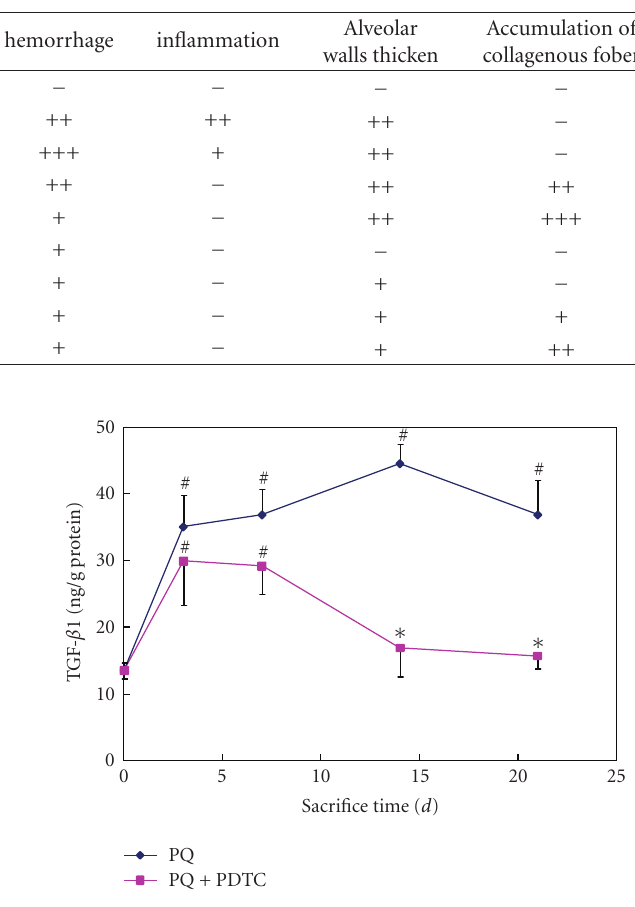
Figure 5: TGF- β 1 level in plasm at sacrifice time from groups of the control, PQ treatment, and PQ+PDTC treatment. TGF- β 1 was expressed as ng/g of protein. Values are given as mean ± SE ( n = 3). # Compared with the control, P < . 05; ∗ compared with the PQ treatment, P < .